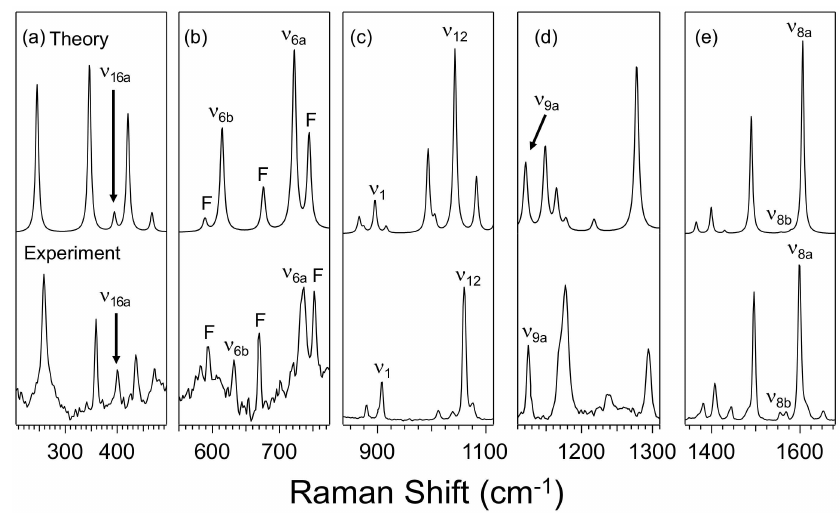
Figure 9. Experimental Raman spectra of PrmF (bottom) compared to its simulated spectrum (top). Peaks in the 550–750 cm − 1 window that are readily assigned to furan vibrations are denoted by F.